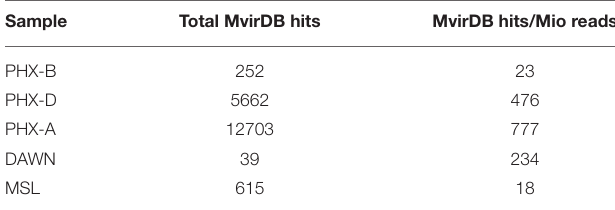
TABLE 3 | Accumulation of virulence factors over time: total number of virulence factors and hits normalized to hits per million reads found in cleanrooms.